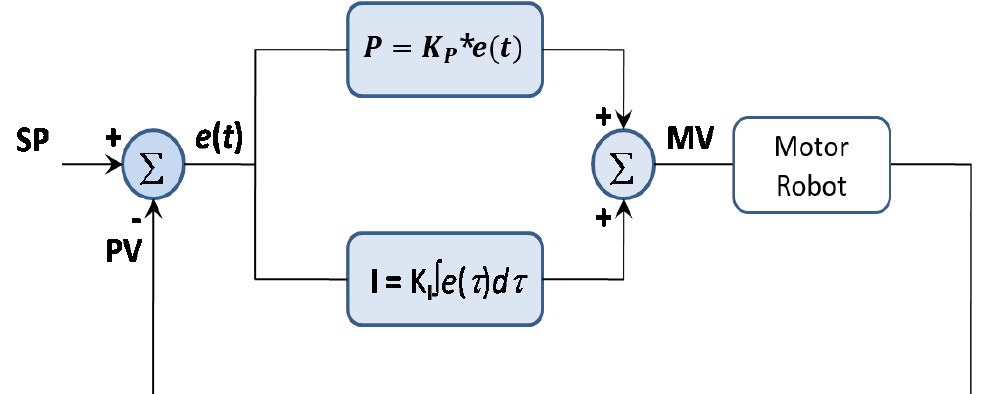
Figure 1. Closed open loop control system.